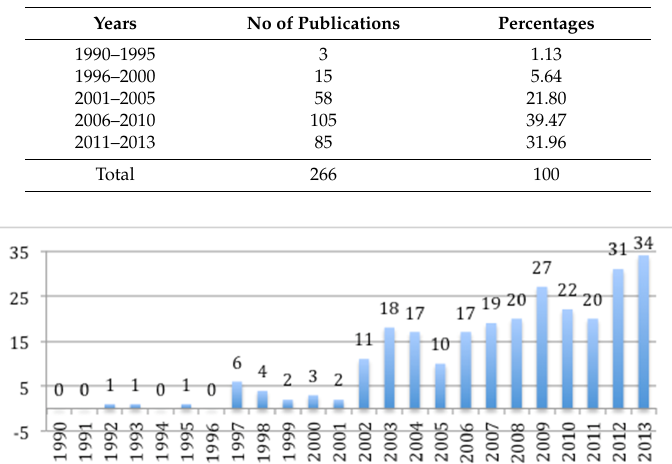
Table 1. The number of the SLW publications in SSCI and A & HCI indices with five-year periods.